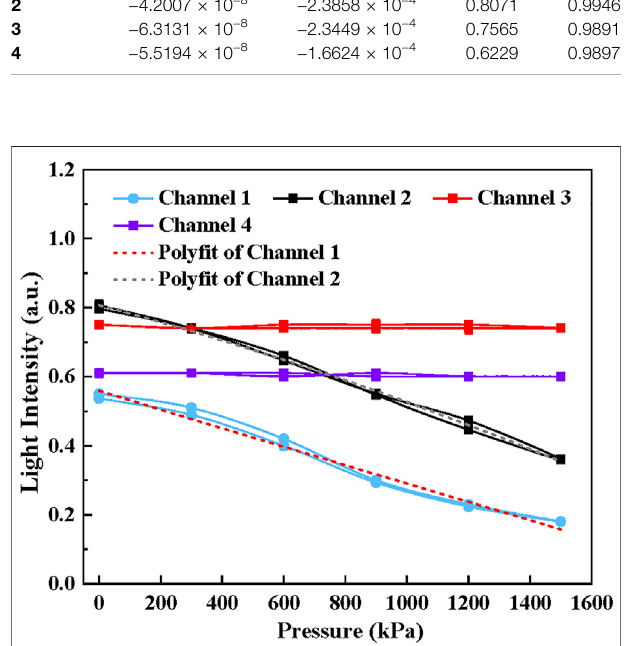
FIGURE 9 | The coupling effects of the proposed sensor when tactel 1 and tactel 2 were pressurized simultaneously.